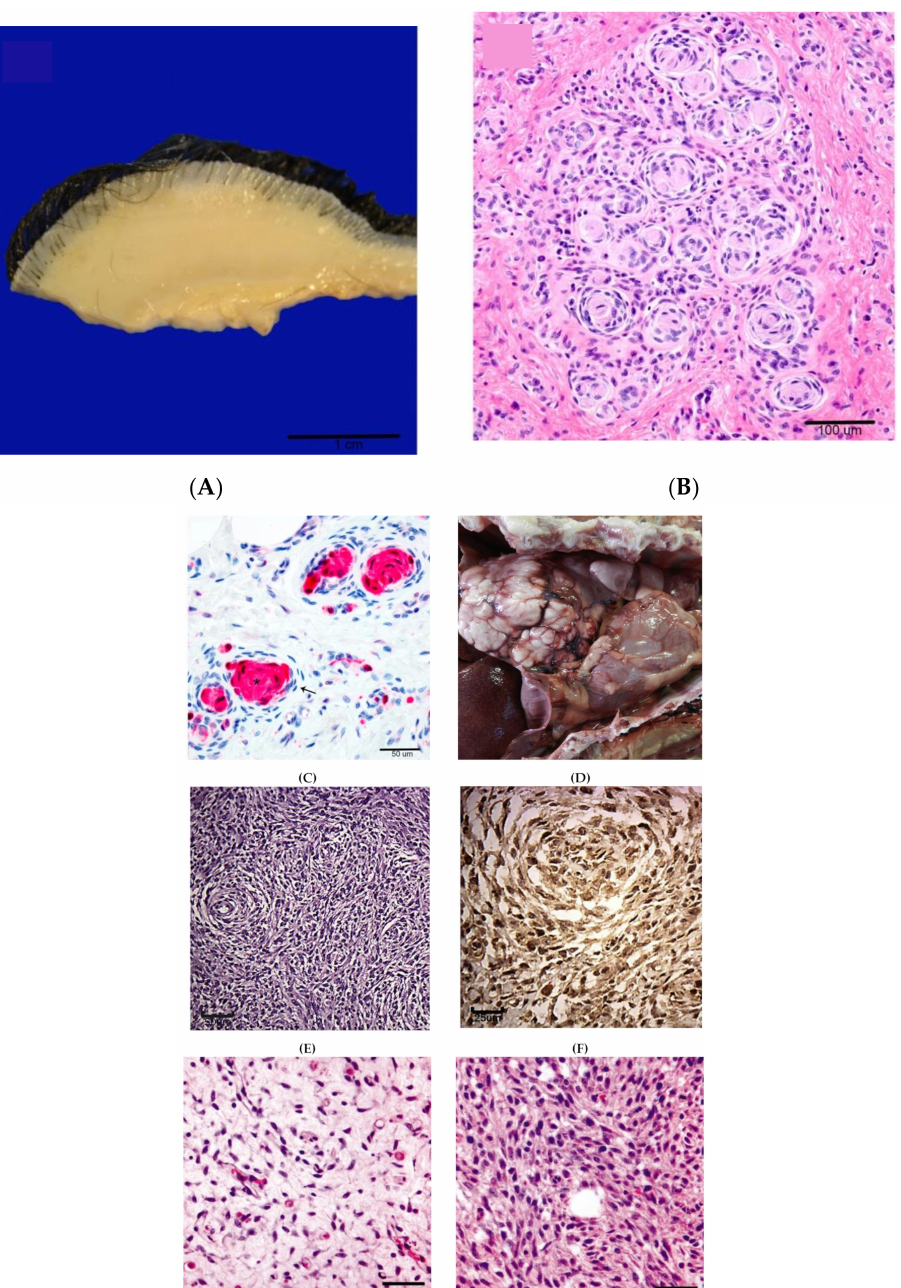
Figure 2. Spontaneous features of NF in dogs. Cutaneous neurofibroma ( A – C ), malignant peripheral nerve sheath tumors (MPNST) ( D – F ), and malignant transformation to MPNST (G-H). ( A ) Gross appearance of a neurofibroma effacing the dermis and subcutis of haired skin [20]. ( B ). Tactile-like structures characterized by parallel stacks or whorls 3–7 cells thick surrounded by a perineurial cell capsule (pseudomeissnerian corpuscles) in cutaneous neurofibroma. H&E [20]. ( C ) S100 immunohistochemistry (IHC) of cutaneous neurofibroma reveals positive staining of the pseudomeissnerian corpuscles (star) but lack of stain uptake in the perineurial cells (arrow) [20]. ( D ) Pulmonary MPNST in Cocker Spaniel dog with concomitant cNF. White multilobular mass in the caudal right lung [61]. ( E ). Section from the pulmonary mass showing dense proliferation of neoplastic cells arranged in interwoven bundles and concentric whorls (Antoni A pattern). H&E [61]. ( F ). Section from the pulmonary mass showing strong expression of S100 IHC [61]. ( G ) Golden Retriever dog with right hind limb enlargement. The sciatic nerve is infiltrated by a hypocellular well-differentiated spindle cell neoplasm diagnosed as benign PNST. Bar = 100 µ m [64]. ( H ) The large soft tissue mass surrounding the right ischium is composed of sheets of malignant spindle cells. Bar = 100 µ m